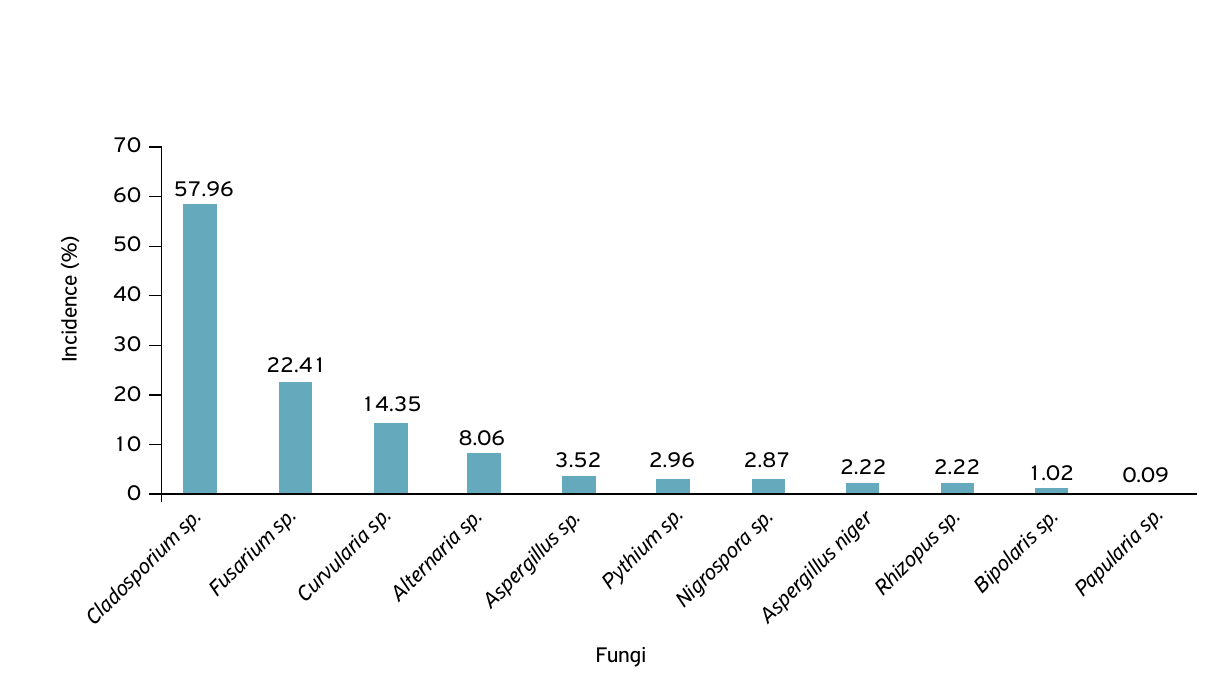
Figure 1. Fungi incident on weed seeds collected in Cerrado areas, Gurupi, Tocantins,